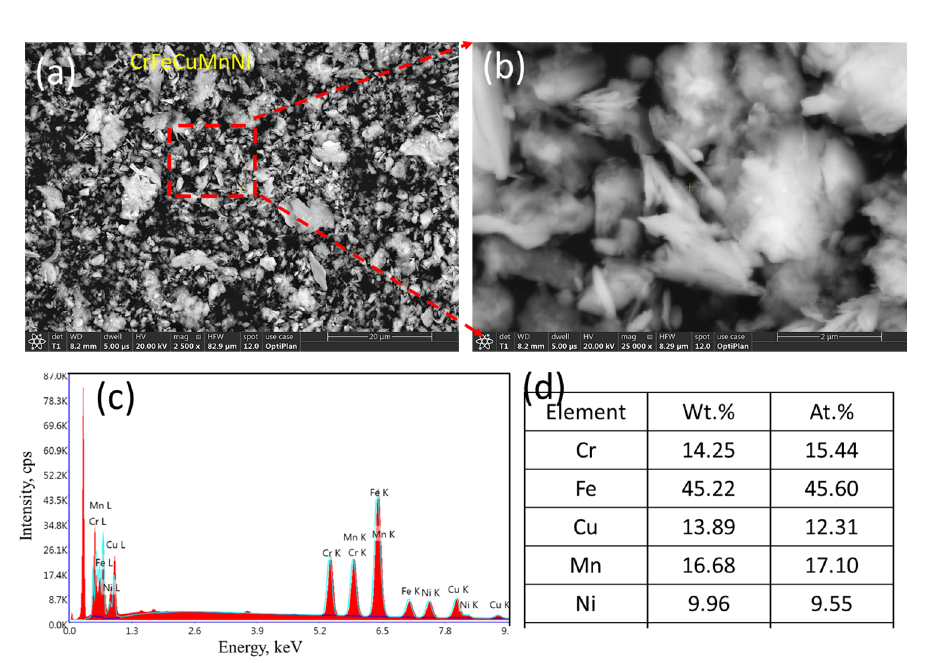
Figure 5. HRSEM images of 50 h milled powders of CrFeCuMnNi: ( a ) low magnification; ( b ) high magnification of ( a ), indicating alloy formation; ( c ) energy dispersive spectrum (EDS) of ( a ); and ( d ) corresponding composition of ( a ).